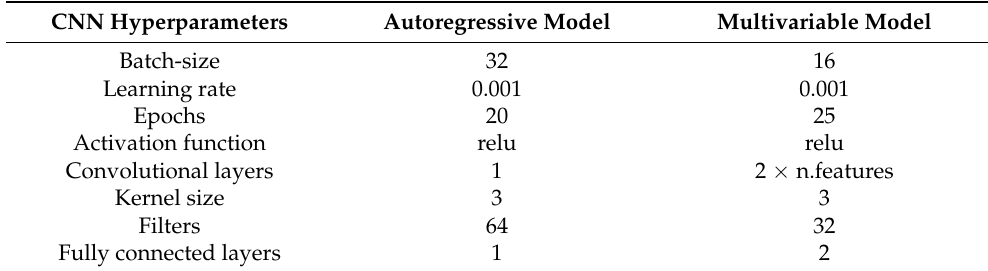
Table 3. Hyperparameters of CNNs in autoregressive and multivariable approaches. CNN Hyperparameters Autoregressive